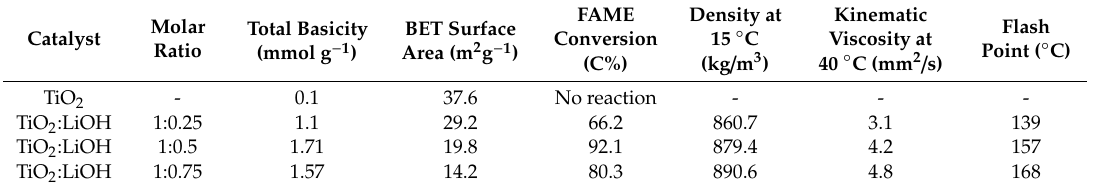
Table 3. The catalytic performance of various catalyst for transesterification of waste cooking oil (WCO).